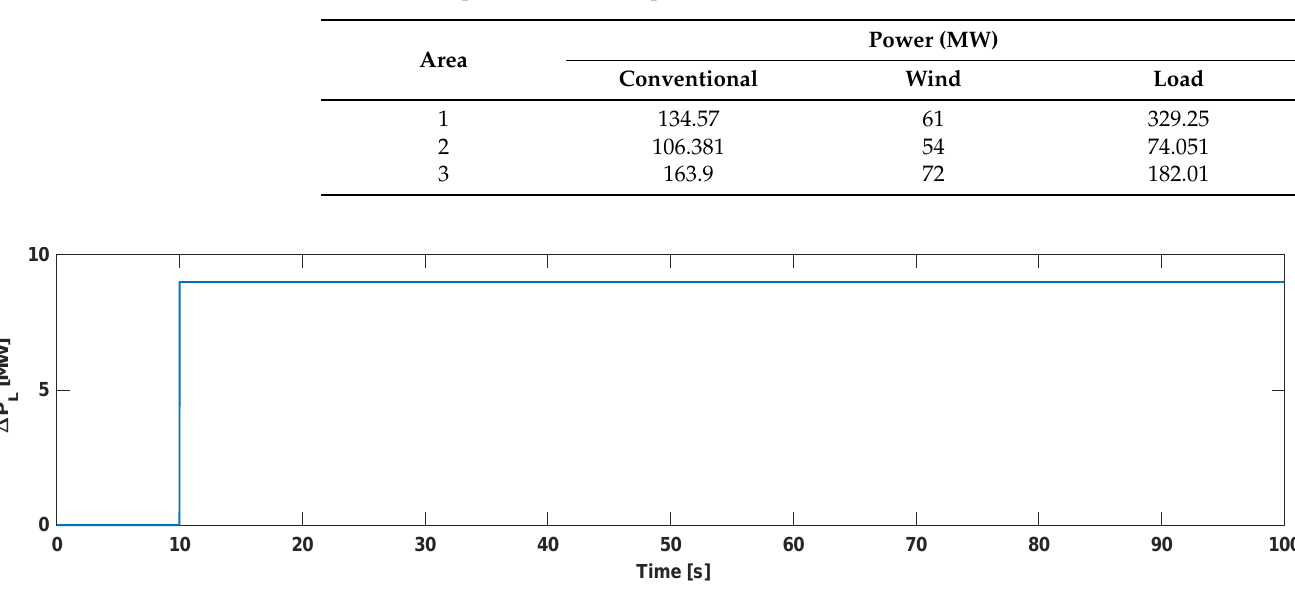
Table 4. Example 2: The value of powers in different areas.